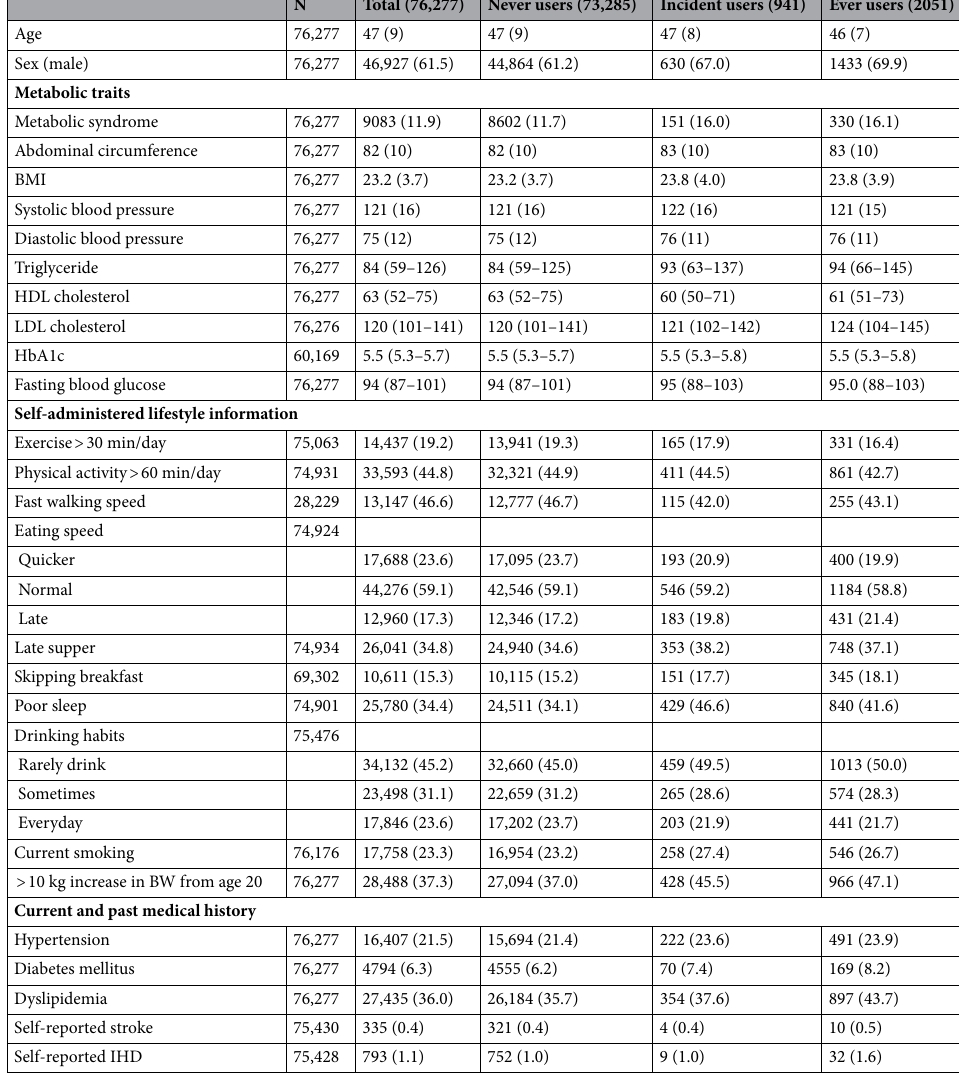
diastolic blood pressure, HDL high-density lipoprotein, LDL low-density lipoprotein, BW body weight, IHD ischemic heart disease, CVD cardiovascular disease, CHF congestive heart failure, NSAIDs non-steroidal anti- inflammatory